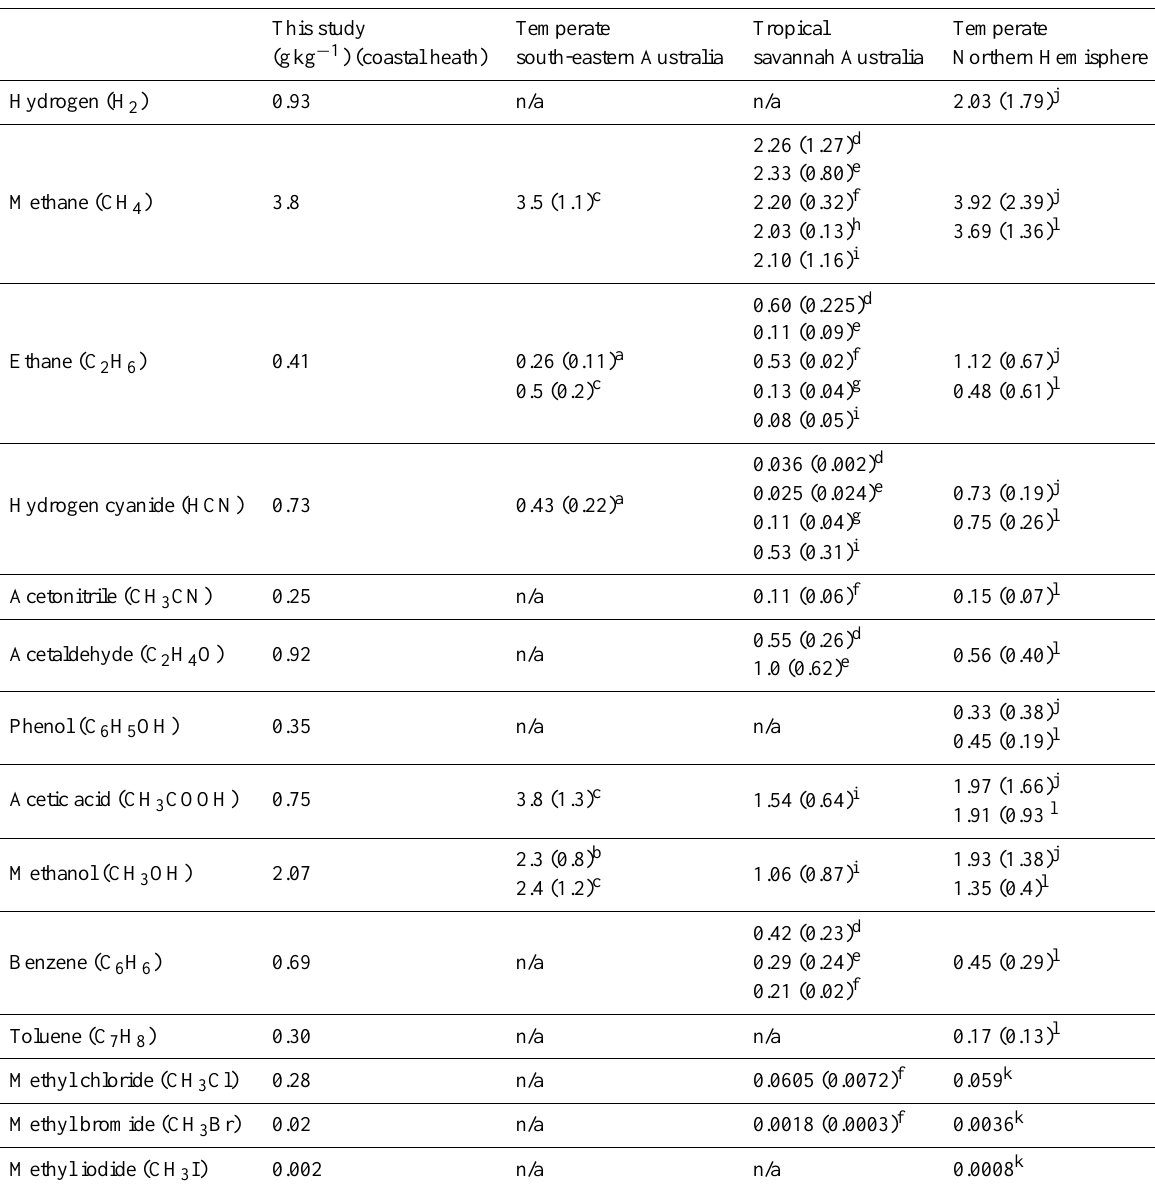
Table 4. Comparison of emission factors with other studies.